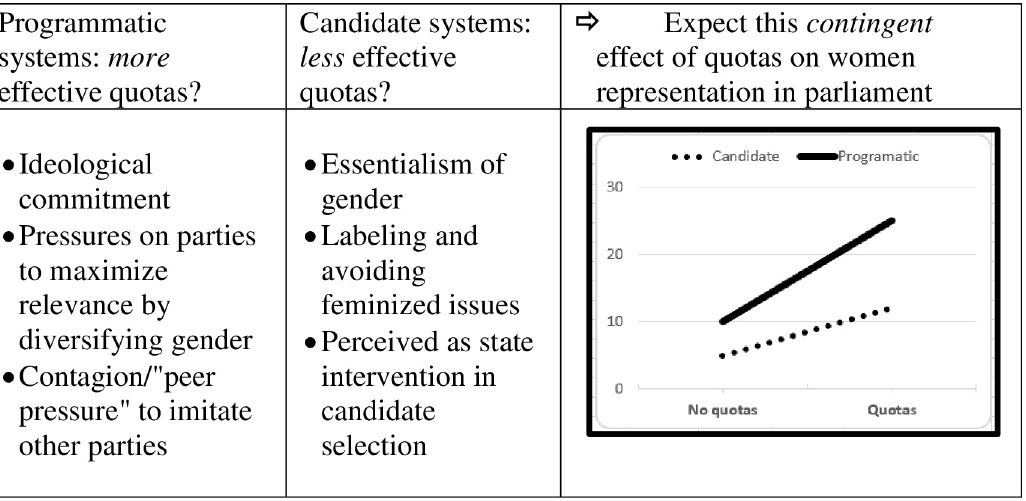
Fig 1. Rationale and hypothesized expectations: Stronger effect of quotas on representation in programmatically oriented systems.